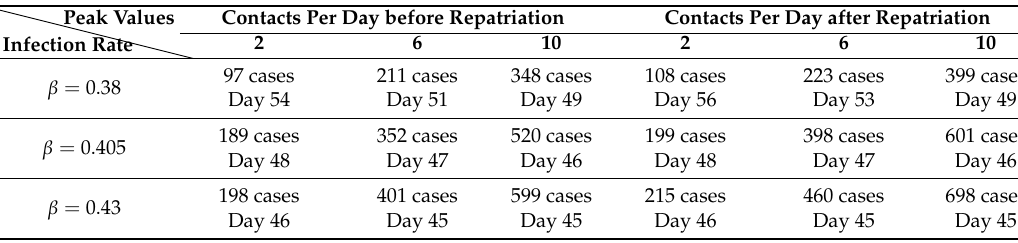
Figure 7. Stochastic simulation results of SIR model with various infection rates and contacts before the repatriation plan. Table 7. Stochastic SIR simulation results.